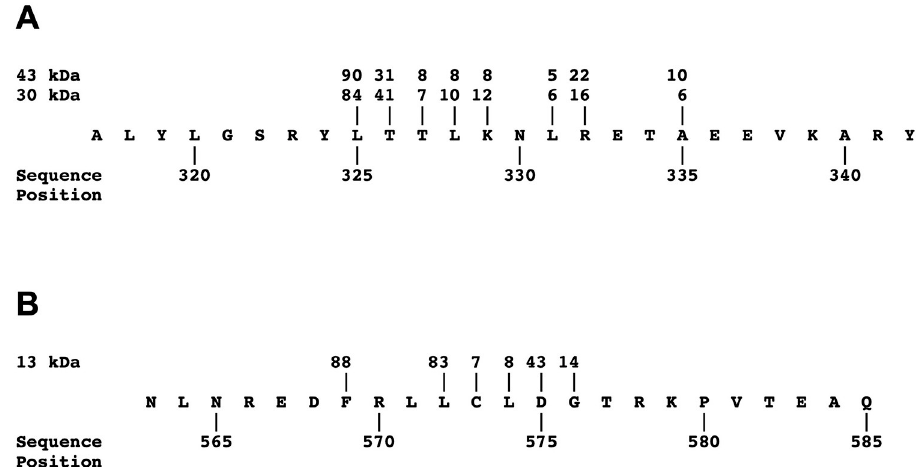
Fig 8. Peptides with non-tryptic N-termini. Two segments of the bLF sequence are shown, where peptides with non- tryptic N-termini were detected at high multiplicities. Panel A shows the region from sequence position 317 to 342 in which non-tryptic N-termini were found for the 43- and 30-kDa fragments, while Panel B shows the region from sequence position 563 to 585 in which non-tryptic N-termini were found for the 13-kDa fragment. Numbers above the sequences show the multiplicity of detection of peptides that start at those particular amino acids. These numbers correspond to the tallest gray-filled plateaus in the plots for these fragments in Fig 7. For clarity, positions with fewer than 5 detections are left